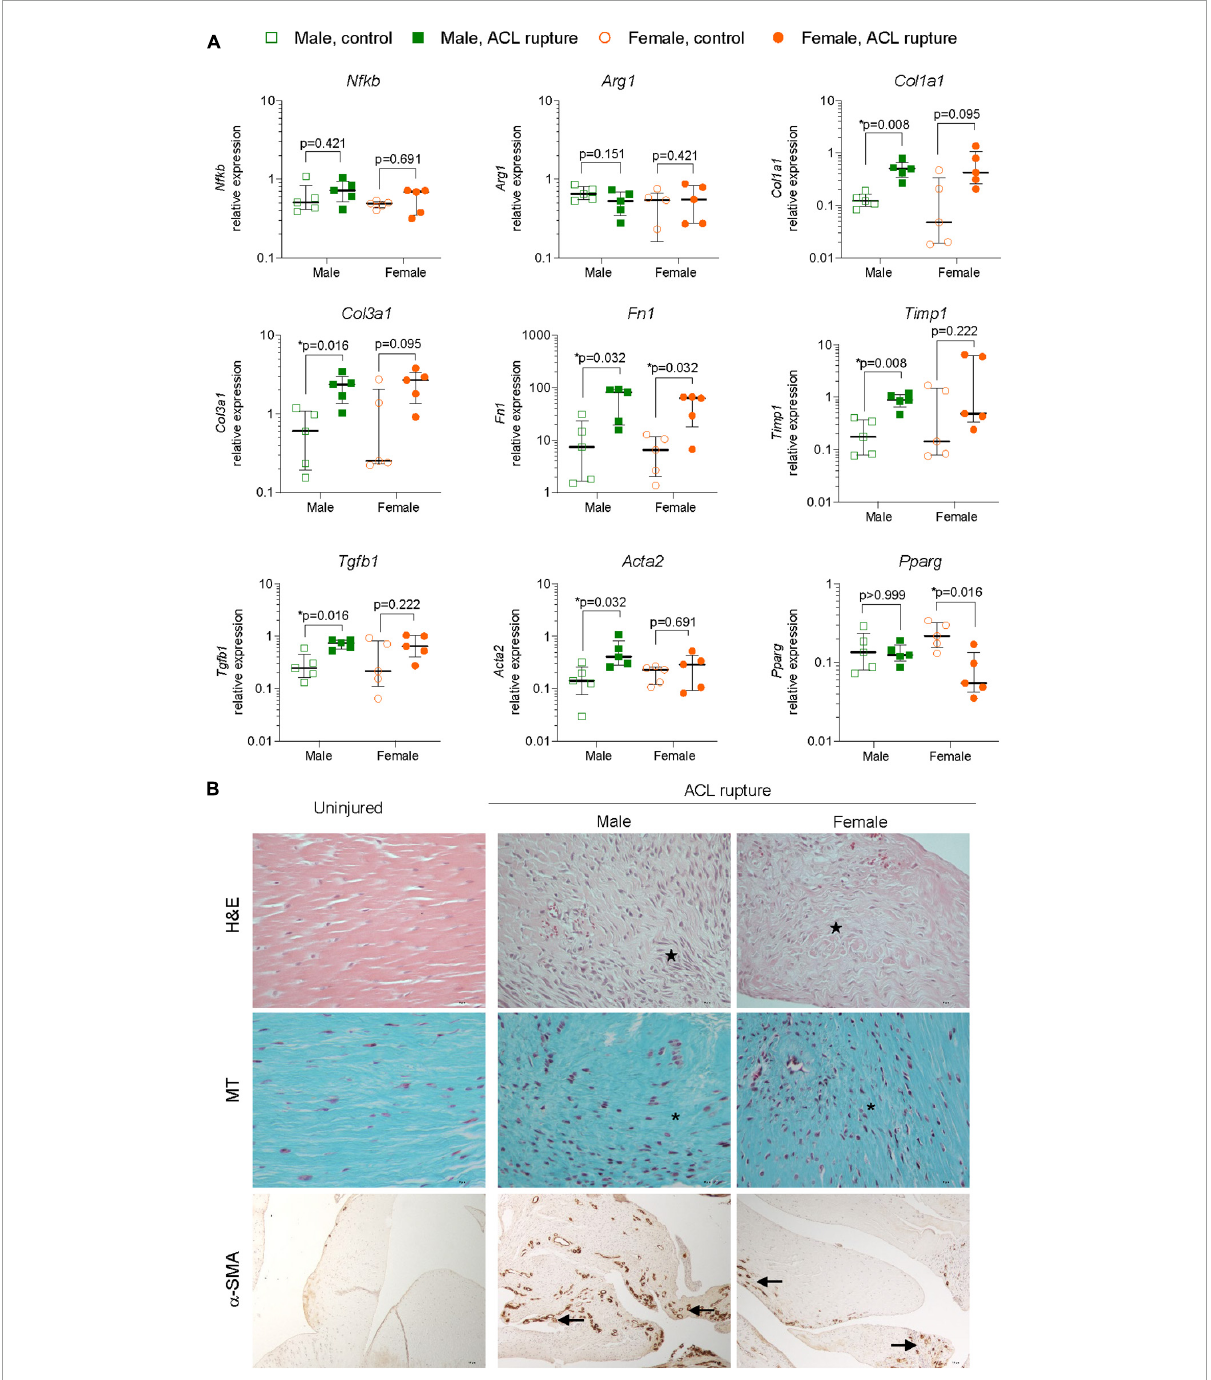
FIGURE4 Inflammation and extracellular matrix (ECM) remodeling in the ACL remnant. (A) Relative expression of markers of inflammation (nuclear factor kappa B, Nfkb; arginase 1, Arg1); ECM components (collagen type 1, Col1a1; collagen type 3, Col3a1; fibronectin, Fn1); ECM remodeling enzymes (tissue inhibitor of matrix metalloproteinase 1, Timp1); and myofibroblast differentiation (transforming growth factor beta 1, Tgfb1; alpha smooth muscle actin, Acta2; peroxisome proliferator activated receptor gamma, Pparg) in the ACL remnant of male and female animals at day 31 post-injury. Data show median ± IQR. Mann-Whitney U -test, * p < 0.05. (B) Representative images of hematoxylin and eosin (H&E, magnification, 400 × ), Masson-Goldner trichrome (MT, magnification, × 400) and α -SMA (magnification, 400 × ) stained sections of the ACL remnant in control and injured knees of male and female animals. H&E-stained sections show loss of uniformity (star) in tissue architecture in ACL-ruptured, compared to control knees. MT staining shows disorganized collagen deposition in ACL-ruptured knees (asterisk), together with increased cellularity (collagen, blue; nuclei, pink). Positive α -SMA staining was associated with increased angiogenesis (arrow) in ACL remnants and adherent synovial tissue, and tended to be lower in female than male injured